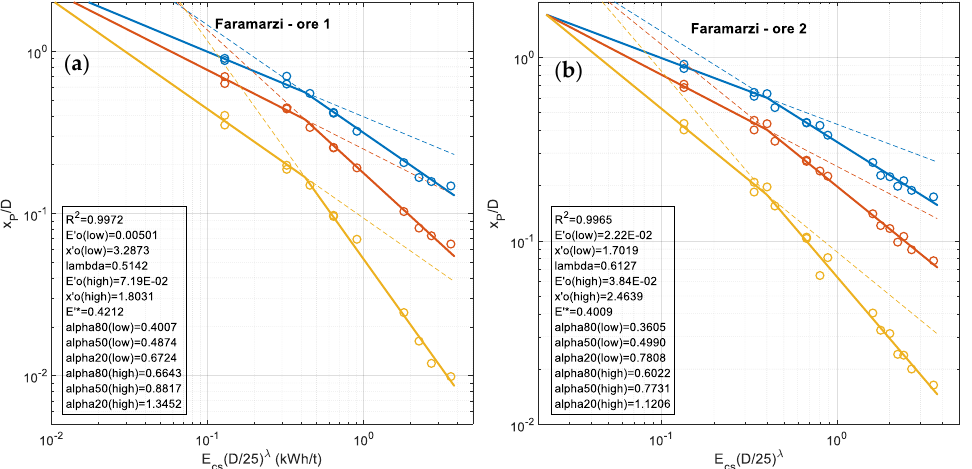
Figure A6. Double fans for Faramarzi’s [ 27] ore 1 ( a ) and ore 2 ( b ).